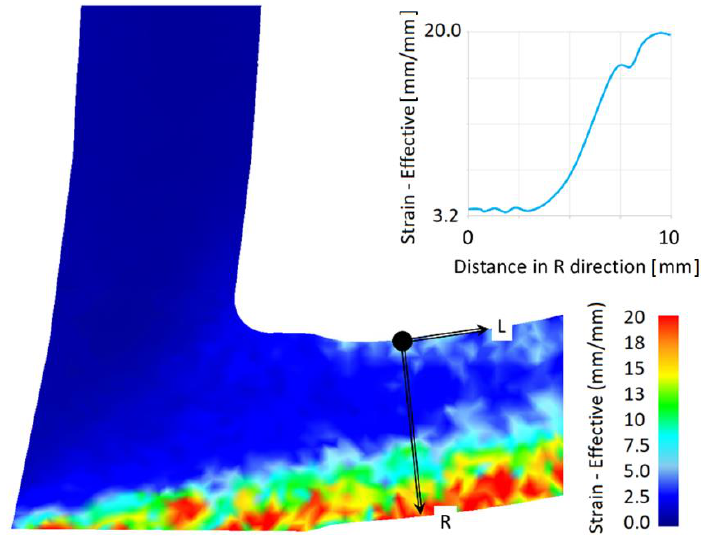
Figure 2. Numerical modelling of the ECAP – Conform process. Strain — Effective distribution after abutment and after diameter reduction of 31%.